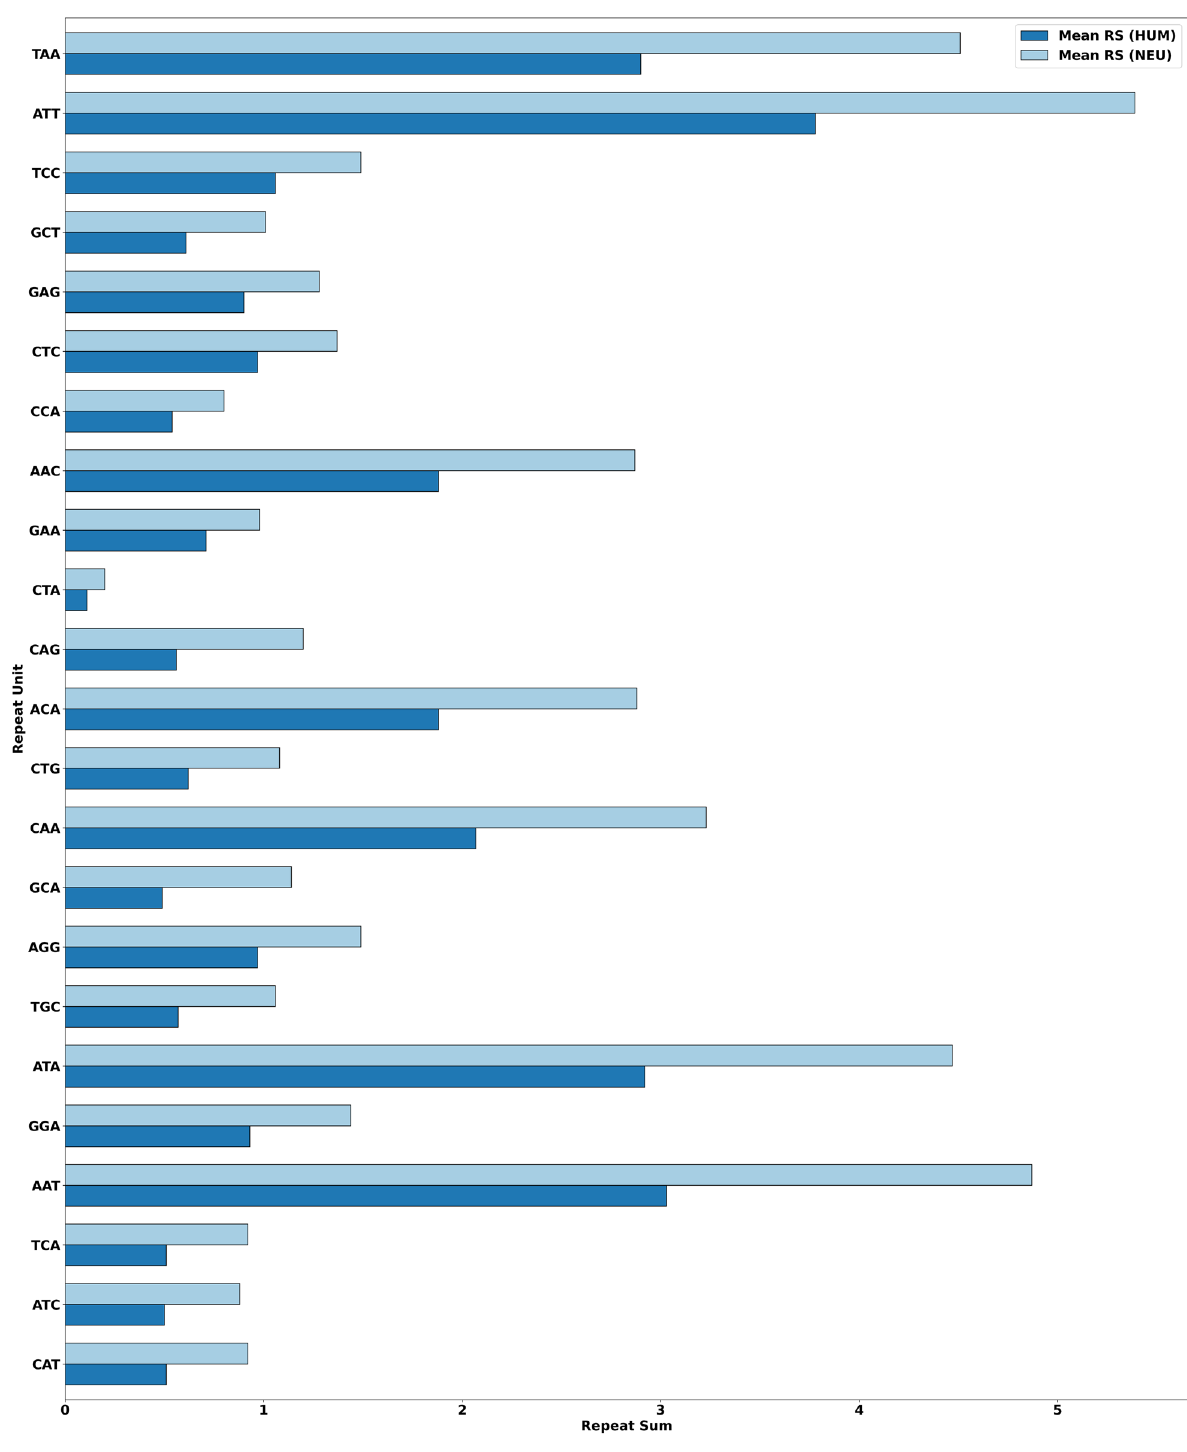
Figure 3. Mean distribution of RS of the most significant RUs (MSRUs) between the two datasets, where MSRU CAT has the lowest adjusted p value, followed by MSRU ATC, and so